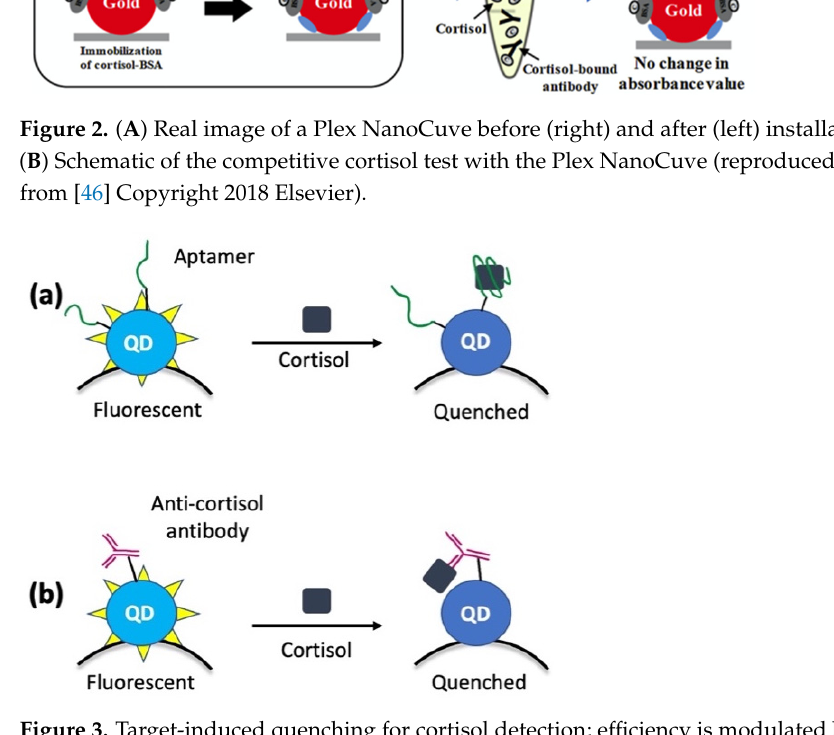
Figure 2. ( A ) Real image of a Plex NanoCuve before (right) and after (left) installation in a cuvette. ( B ) Schematic of the competitive cortisol test with the Plex NanoCuve (reproduced with permission from [46] Copyright 2018 Elsevier).